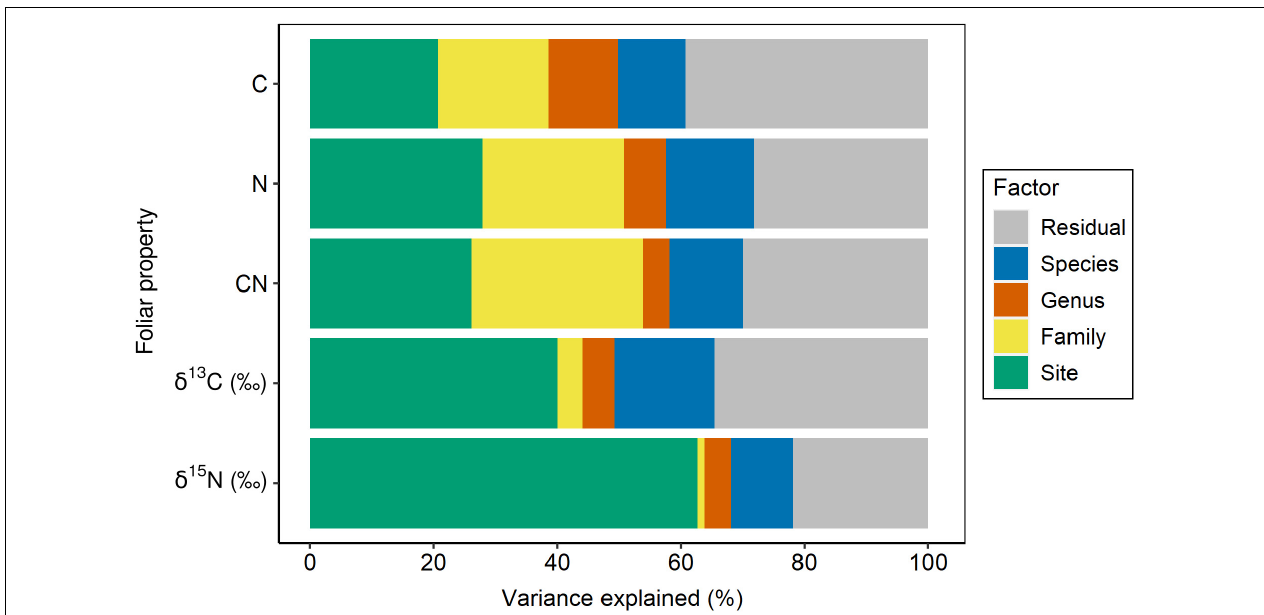
FIGURE 2 | Partitioning of variance for foliar C and N concentration, C:N ratio, δ 13 C, δ 15 N into taxonomy (nested design: family/genus/species), site, and residual. Foliar properties are sorted from the less to more site